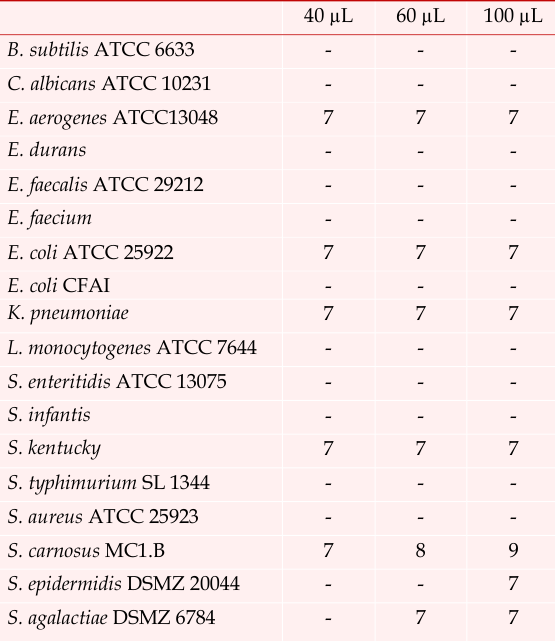
Disk diffusion test results (Inhibition zones in